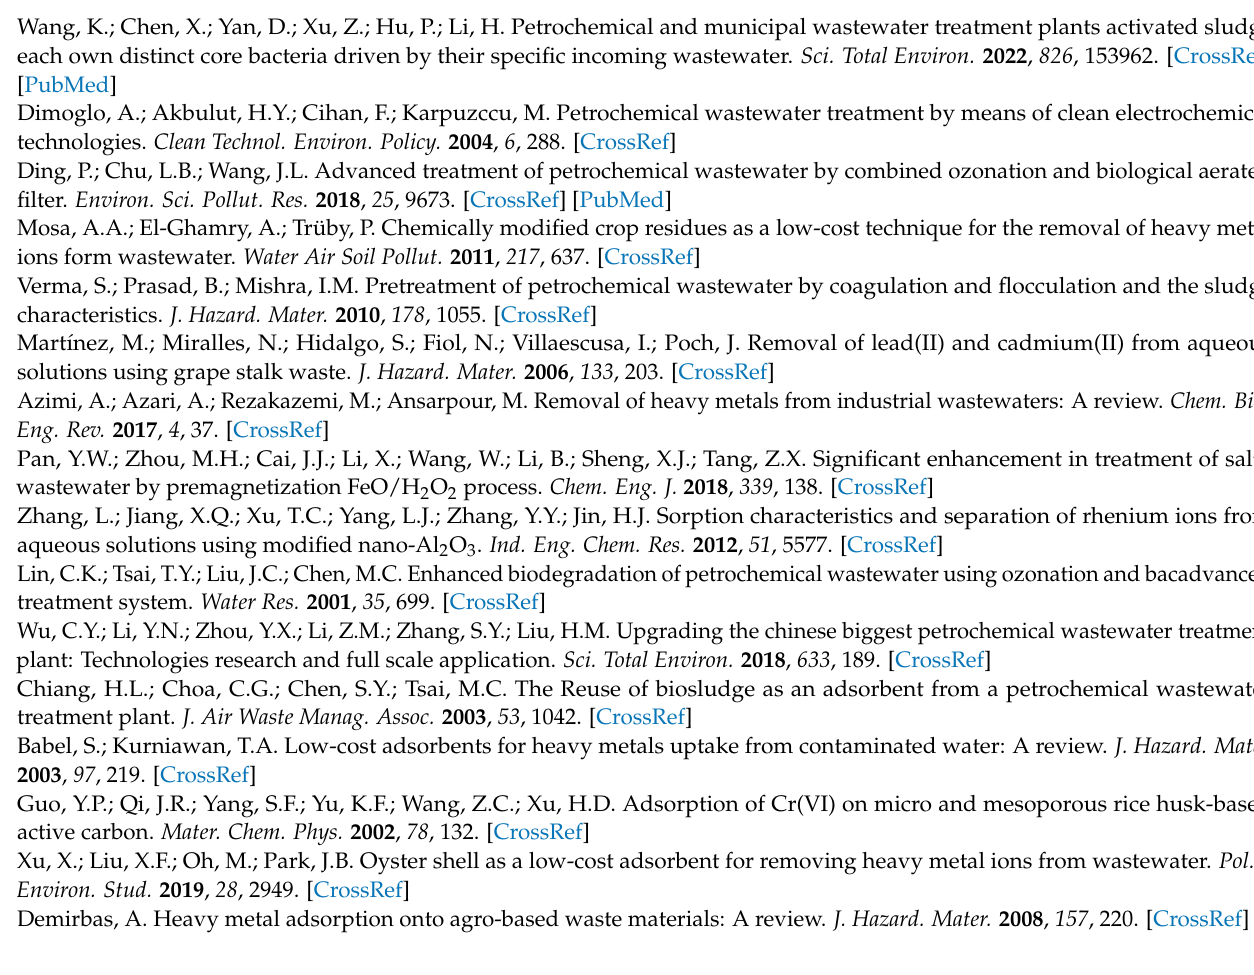
Table S2: The adsorption performance by 10%-Fe 3 O 4 @ SC adsorbent at lower pH; Figure S4: Test data fitting curve of Langmuir adsorption isotherm model; Figure S5: Test data fitting curve of Freundlich adsorption isotherm model; Table S3: The experimental data of Langmuir isotherm at different temperatures; Table S4: The experimental data of Freundlich isotherm at different temperatures; Table S5: Parameters of adsorption kinetic and intraparticle diffusion model; Figure S6: The plot dependence of ln(Q e /C e ) on